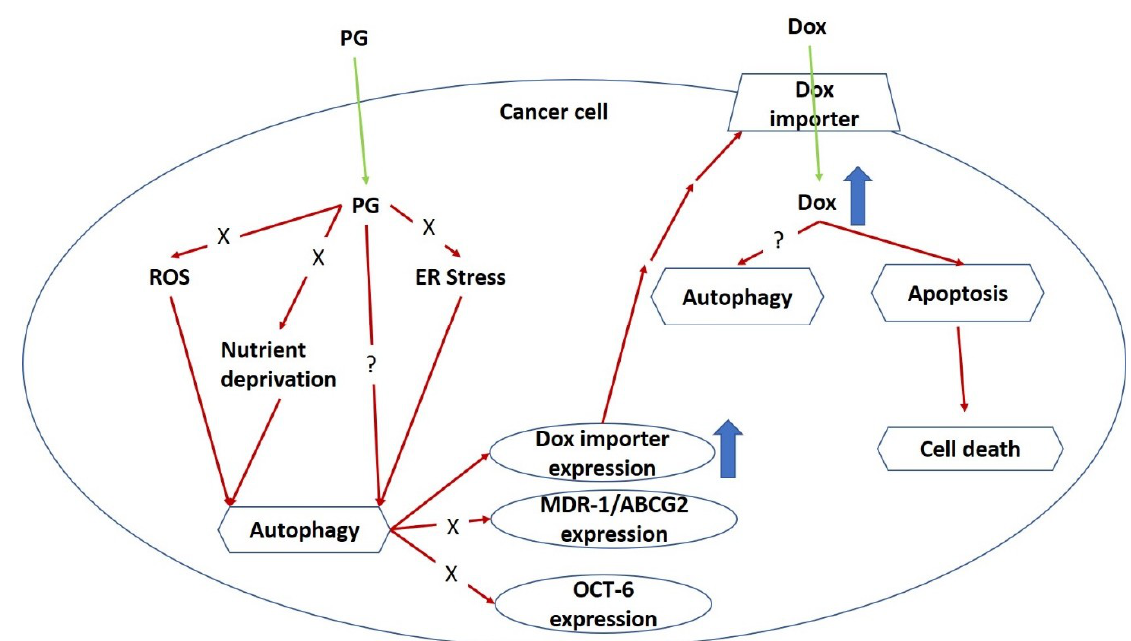
Figure 8. Potential mechanism of PG-priming doxorubicin cytotoxicity enhancement. “X” indicates not according to this mechanism. “?” illustrates still unknown. ER, endoplasmic reticulum; ROS, reactive oxygen species.